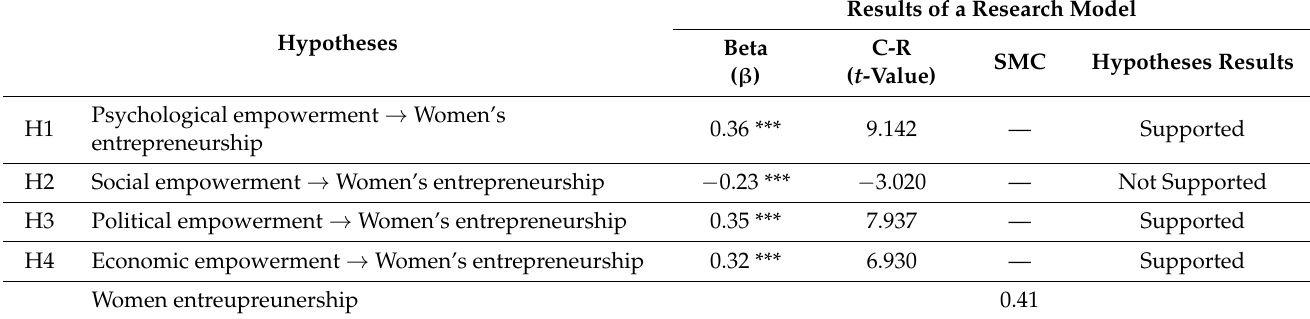
Table 3. Hypothesis